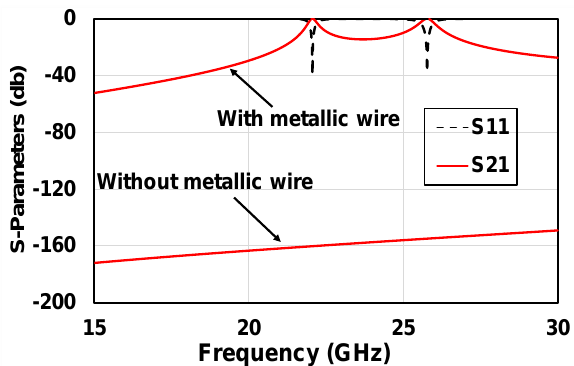
Fig.3. S-parameters with and without metallic wire